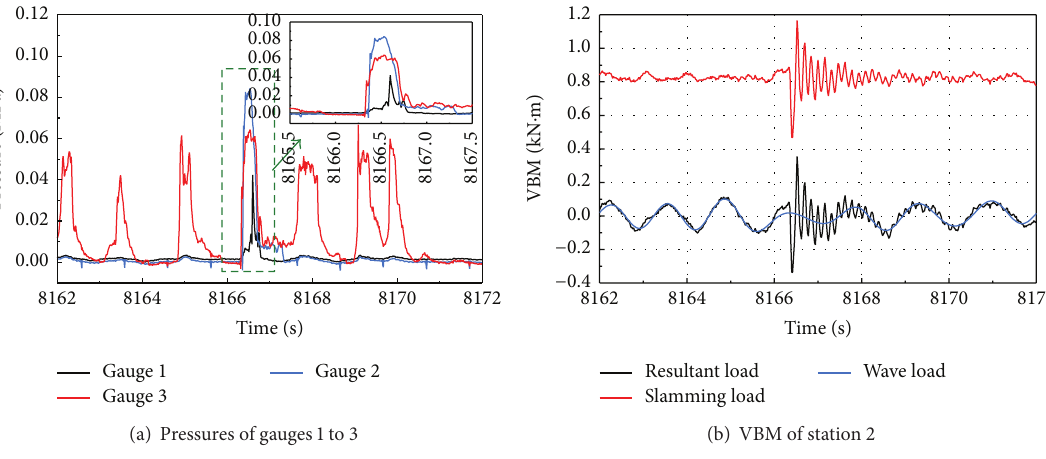
Figure 17: Time histories of pressures and loads in an extremely short interval.